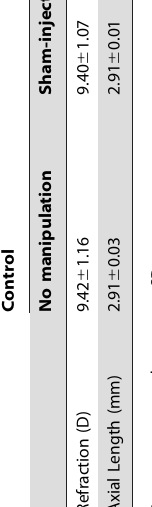
values were offset by the negative shift in refraction and the excess in axial length, induced by the diffuser. When the Wnt pathway was activated with Norrin or inhibited with DKK-1, refraction and axial length were different from those in the ‘‘no manipula- tion’’ control group (Table 3, Fig. 5; two-way ANOVA).